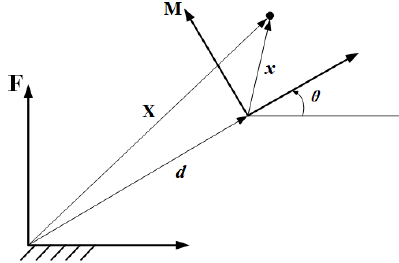
Figure 2. Planar displacements. Figure 3. Relative pole of the two